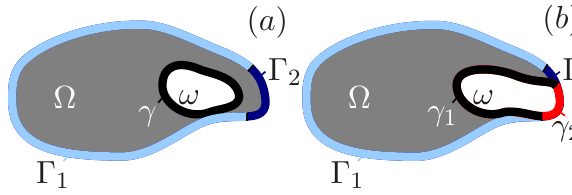
Fig. 2. Description of the evolution of the boundaries of the EPL. Panel (a) shows the transitional phase where (cid:127) is the IDS domain with 0 1 and 0 2 the Neumann and Dirichlet boundary conditions, respectively; ω is the domain in which the EPL equation is solved with a zero flux boundary condition γ . In panel (b) , the EPL is effective; in this case the boundary is such that γ = γ 1 + γ 2 where γ 2 = γ T 0 2 is a Dirichlet boundary condition and γ 1 is a zero flux boundary